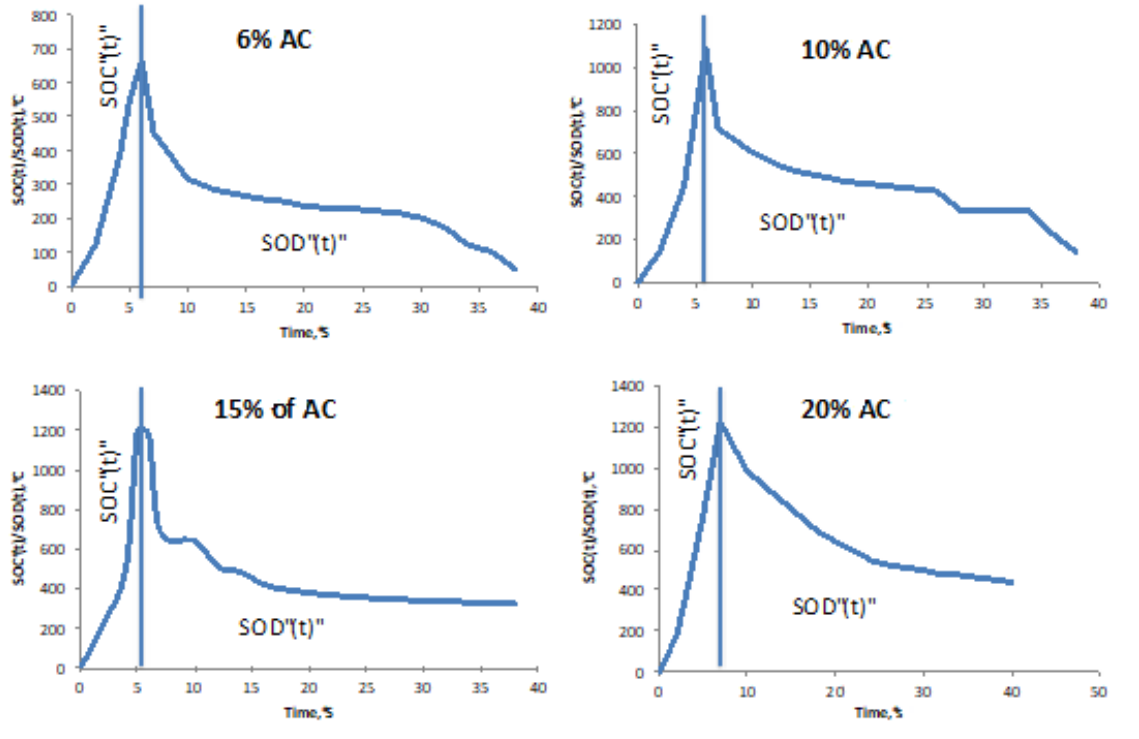
Figure 22. SoC(t) and SoD(t) at OSSC laboratory